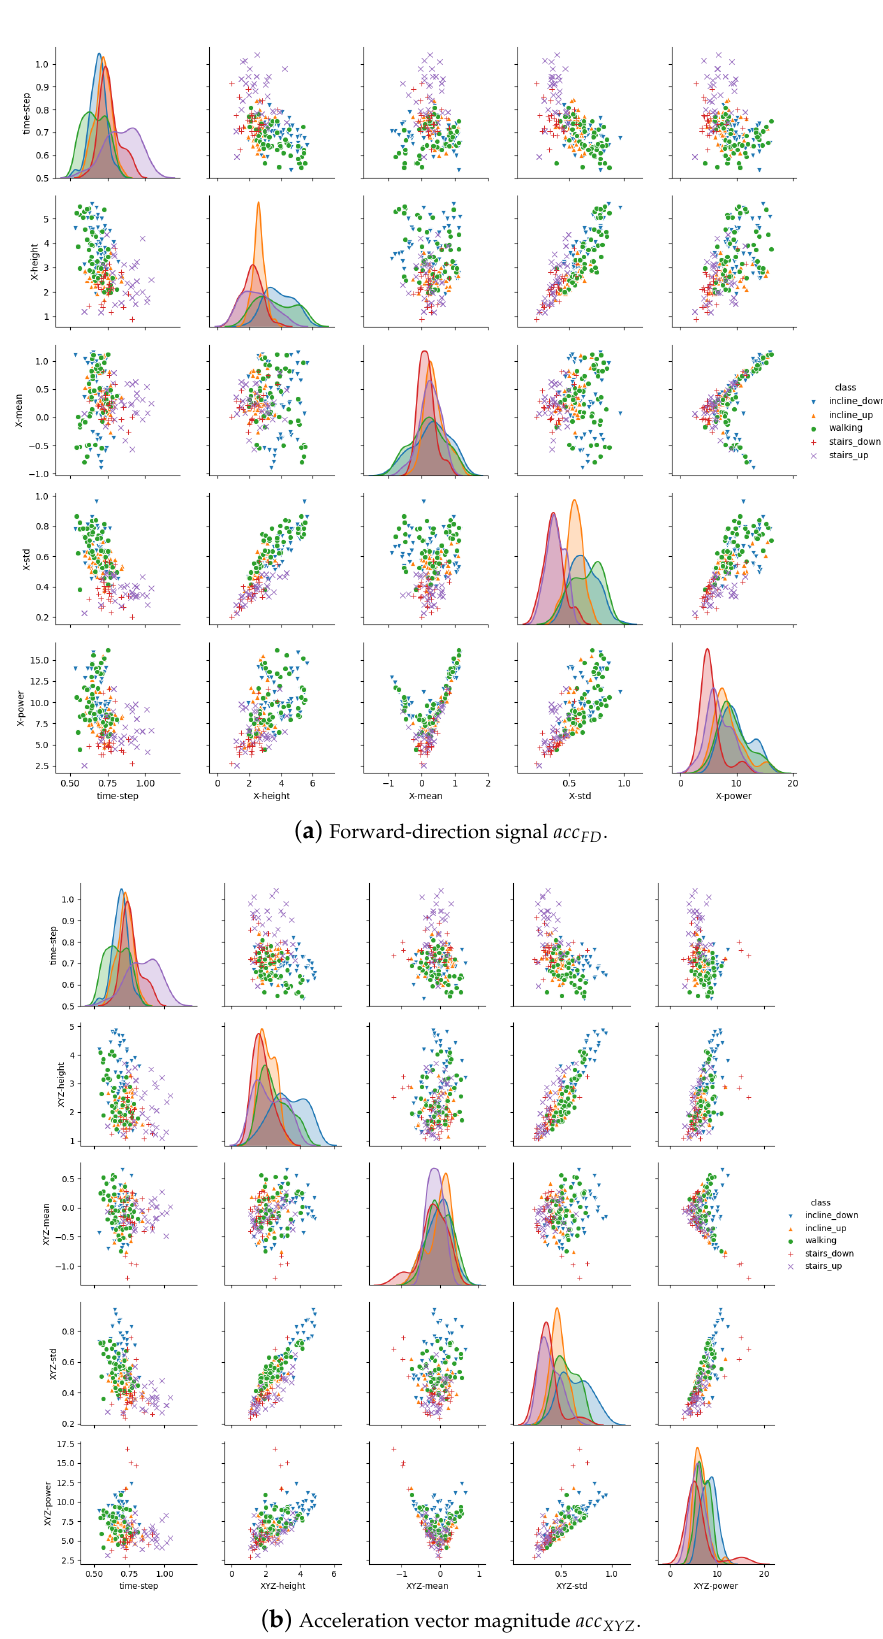
Figure A2. Visualization of feature space in forward-direction signal ( a ) and acceleration vector magnitude ( b ) from IMU